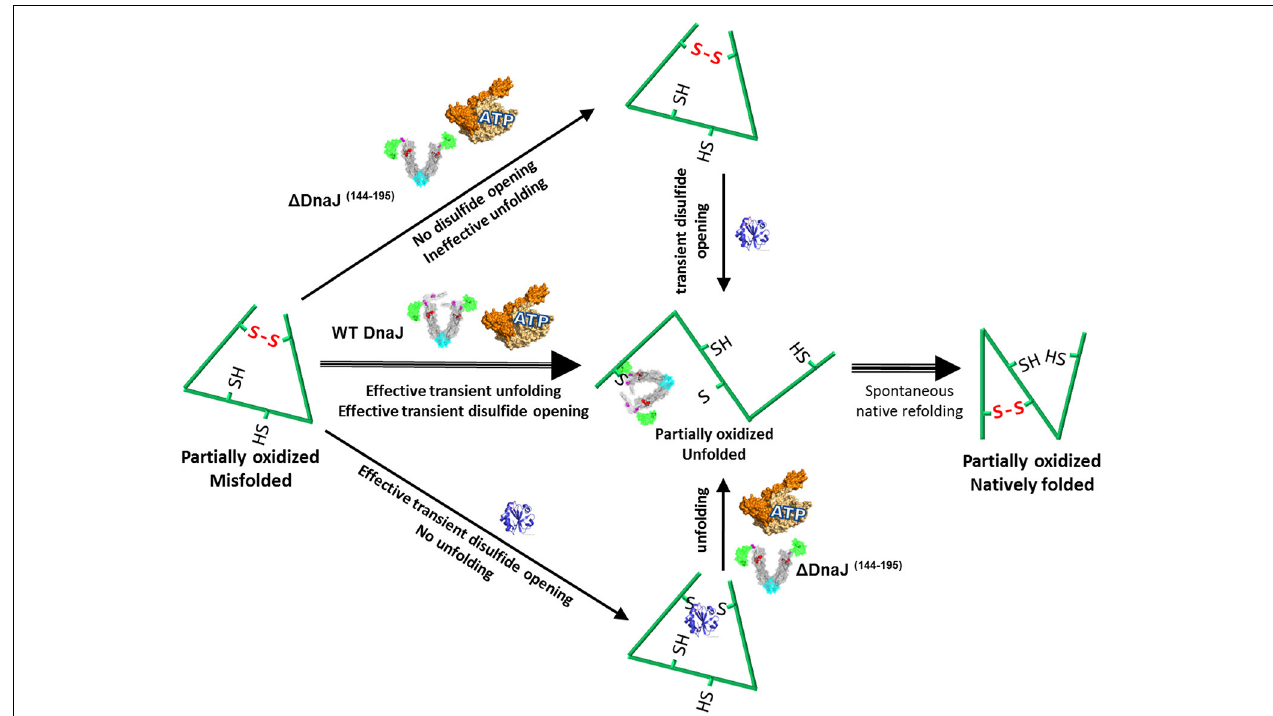
FIGURE 5 | Proposed model for the concerted dithiol-oxidoreductase and unfoldase activities by type I J-co-chaperones. Under mildly oxidative conditions, a stress-misfolded polypeptide may be stabilized both by misaligned disulfide bonds and by strong cooperative hydrophobic interactions, for example in wrong beta sheets. Wild type DnaJ can recruit DnaK to forcefully unfold wrong beta structures and at the same time catalyze the transient opening of wrong disulfide bonds. Thus a partially